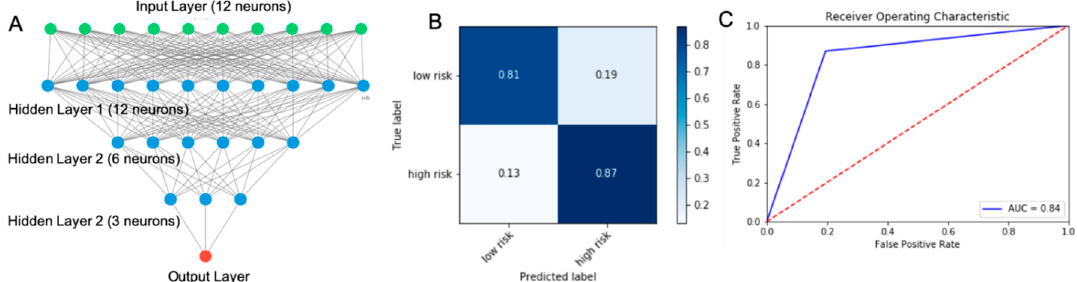
Figure 4. Structure and performance of our best machine learning based model in predicting high and low risk severity score evaluated by confusion matrix and AUC of ROC. The best machine learning model with the highest performance is a deep neural network model with 12 neurons in the input layer including age, total cholesterol, triglyceride, low-density lipoprotein (LDL), high-density lipoprotein (HDL), systolic blood pressure, HbA1c, glucose, sex and Id3SNP after all these inputs were normalized and transformed. The model contained 12 and 6 neurons in the next sequential layers and an output layer ( A ). The model performance was evaluated on 82 patients in the testing set. With our best model, the low risk group was predicted NPV of 81% and high risk group with PPV of 87% ( B ). ROC plot showing the performance of the model (blue line) with an AUC of 0.84 and random (dashed red line) for comparison ( C ).